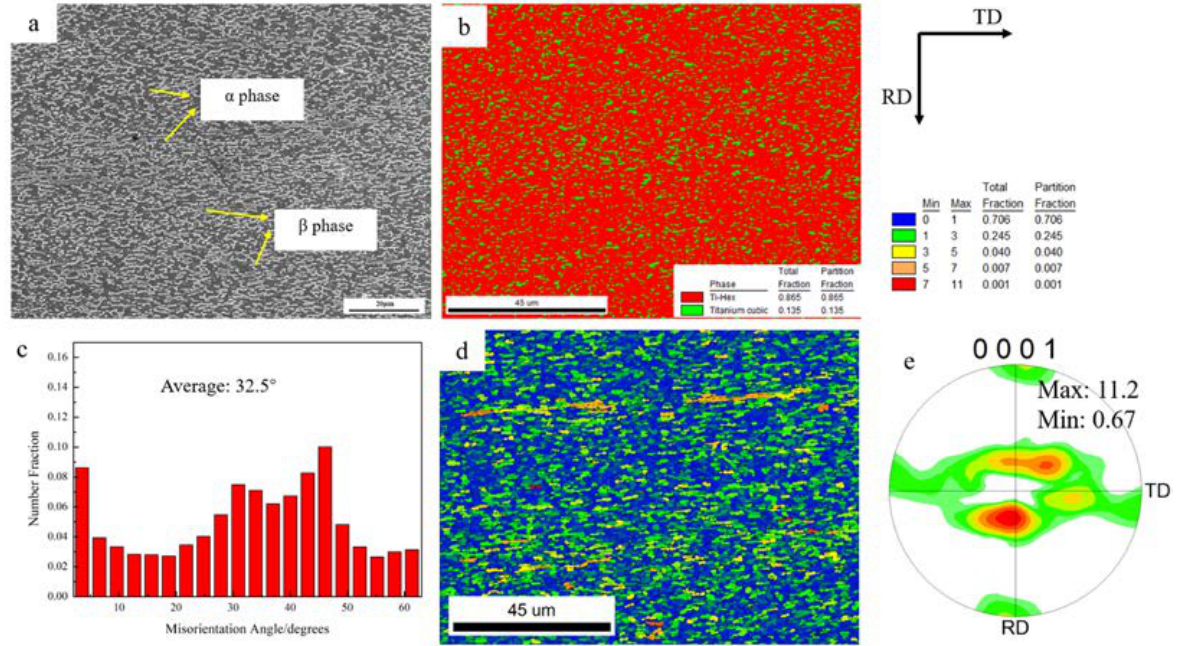
Figure 4. Microstructure and texture of the initial sheet: ( a ) SEM image, ( b ) phase fraction map, ( c ) misorientation angle chart, ( d ) grain orientation spread map, and ( e ) (0001) pole figure of α phase.